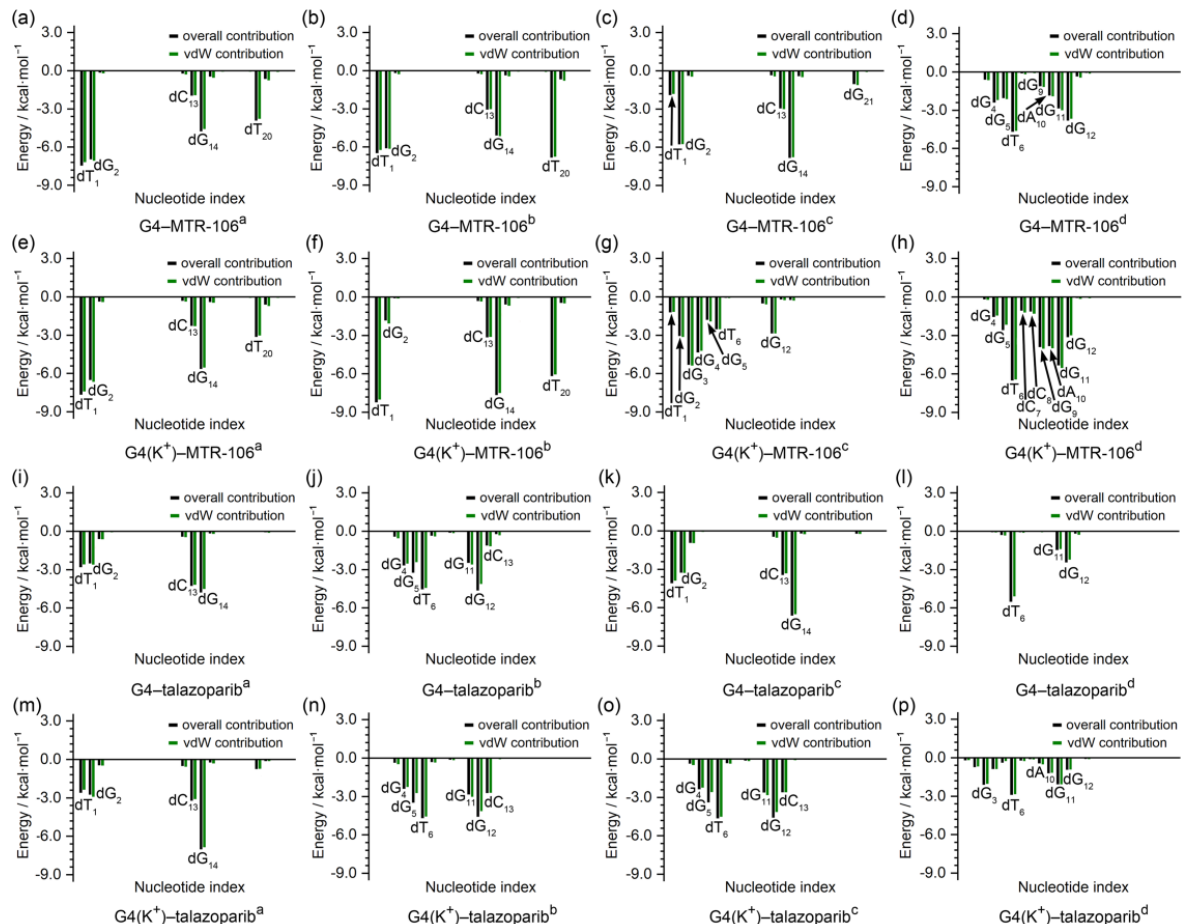
Figure 7. Per-nucleotide decomposition of binding-free energy. The per-nucleotide-based overall and vdW contributions are represented as black and green columns, respectively.